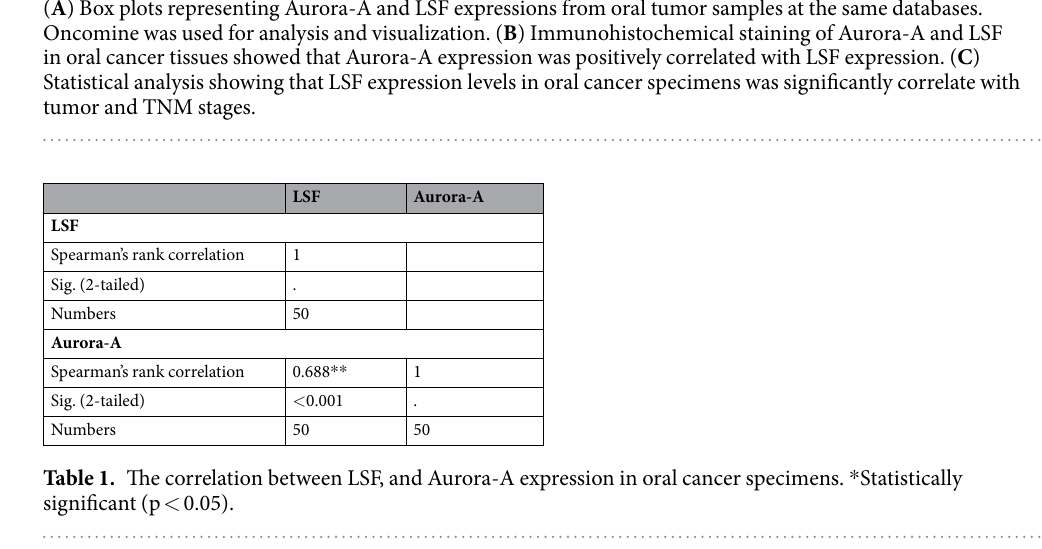
mice, but also modulated metformin-suppressed the proliferation rate of cancer cells 27 . Aside from the metabolic diseases, AMPK activation by metformin may regulate cell cycle progression. For instance, AMPK diminished the c-Myc expression via increasing miR-33a expression 28 . Additionally, AMPK phosphorylated p53 at Ser15 resulted in cell cycle arrest 29 . AMPK-independent mechanisms have been reported to demonstrate the anti-cancer properties of metformin. Metformin can prevent DNA damage and mutation by inhibiting ROS generation by complex I 30 . In prostate can- cer, REDD1, a negative regulator of mammalian target of rapamycin (mTOR), is regulated by p53 and is required for metformin effects on cell-cycle arrest 31 . Inactivation of Stat3-Bcl-2 pathway contributes to metformin-induced